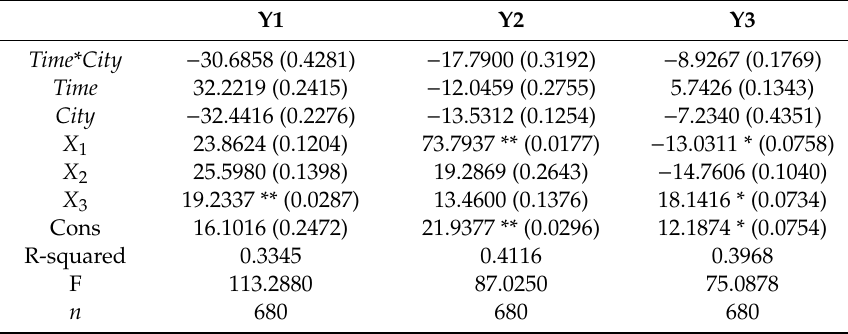
Table 7. Test results of parallel trend hypothesis.